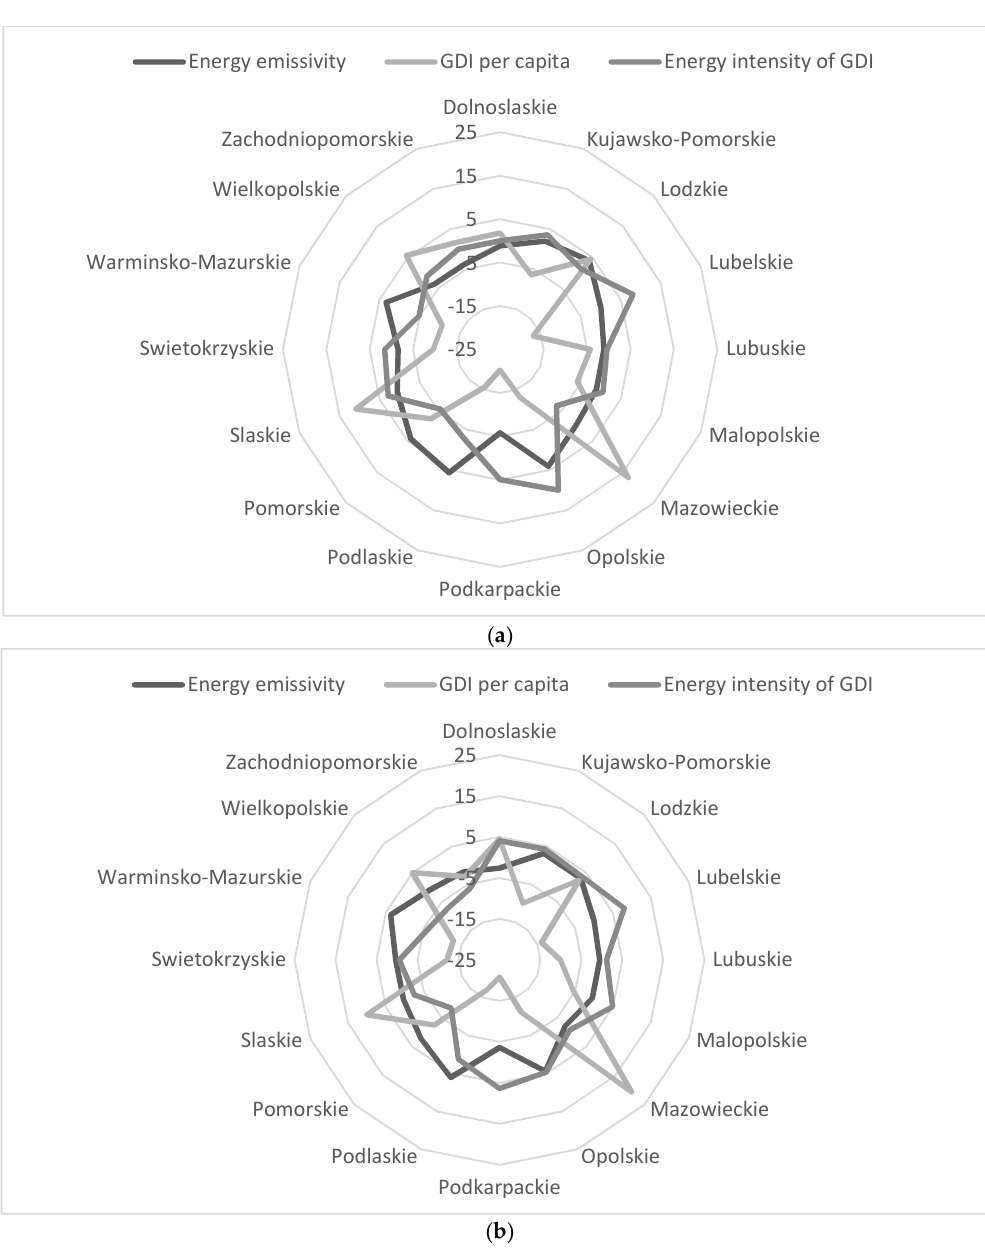
Figure 5. Contribution of factors to the difference in regional CO 2 emission per capita in 2006 ( a ) and 2017 ( b ) [percentage points]. Source: Own calculation.